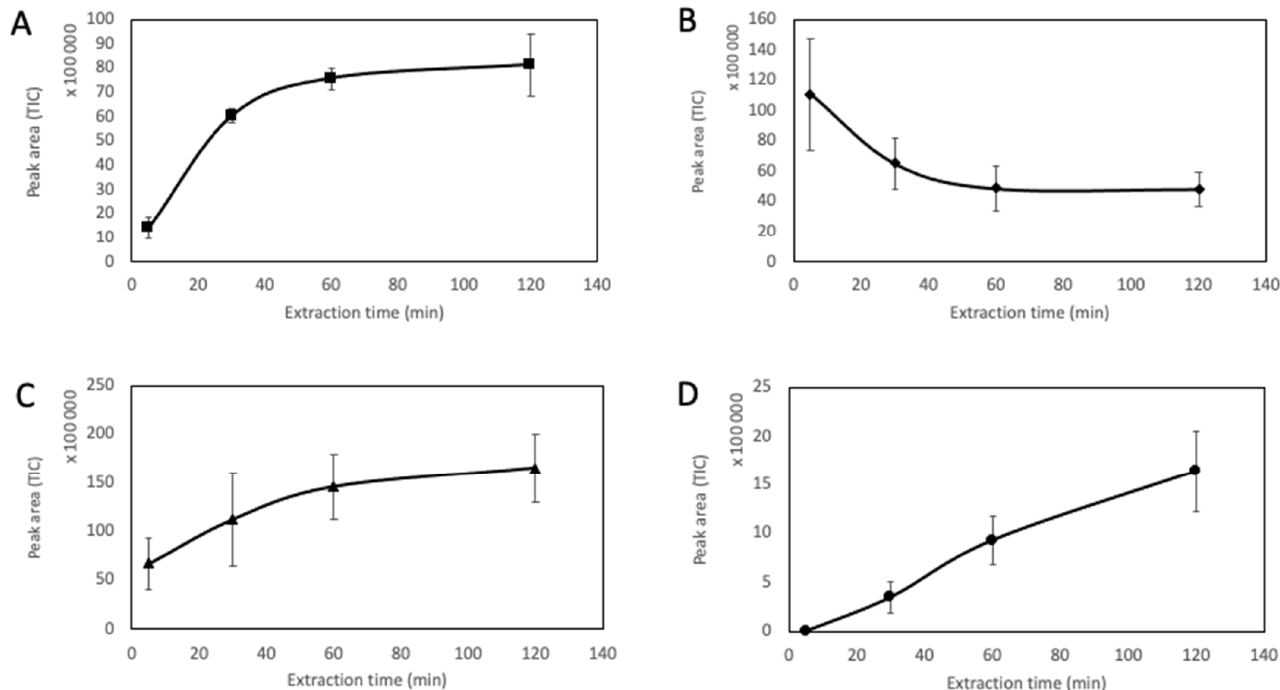
Figure 2. Extraction time curves with standard deviations of four selected compounds of the model mixture ( n = 3). ( A ) furfural; ( B ) α -pinene; ( C ) β -caryophyllene; ( D ) (E)- β -damascenone.